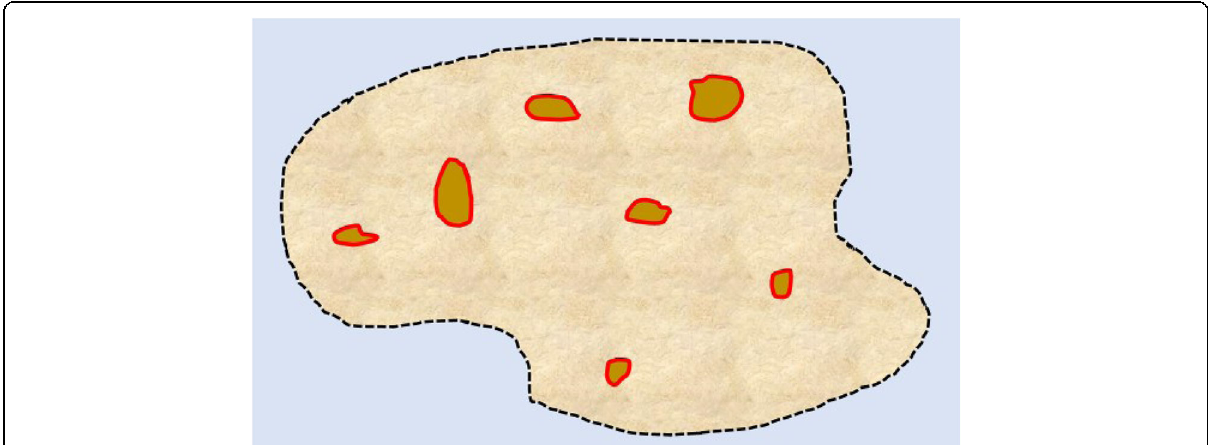
Fig. 15 A diagram depicting expression of PD-L1 positive tumor infiltrating immune cells (marked by red border) in an area of tumor cells (marked by black dotted line). The proportion of tumor area occupied by PD-L1-positive immune cells of any intensity determines the immune cell (IC)